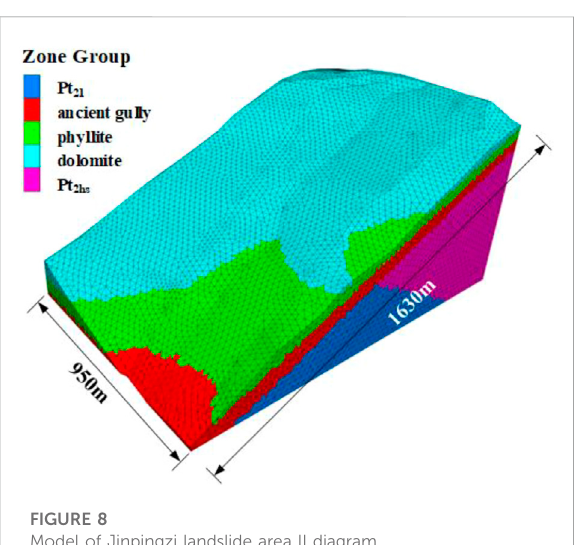
FIGURE 8 Model of Jinpingzi landslide area II